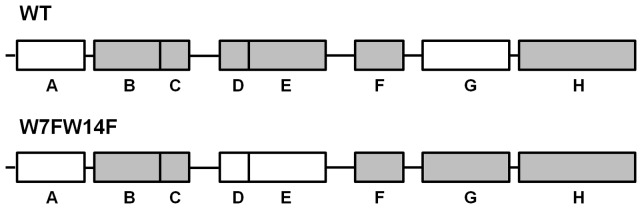
Solvent accessible regions in the wild-type and W7FW17F apomyoglobin.Schematic representation of the A-H helices in the wild-type and W7FW14F apomyoglobin. Solvent accessible helices for both protein are shown in grey. Experimental conditions are described in [51].